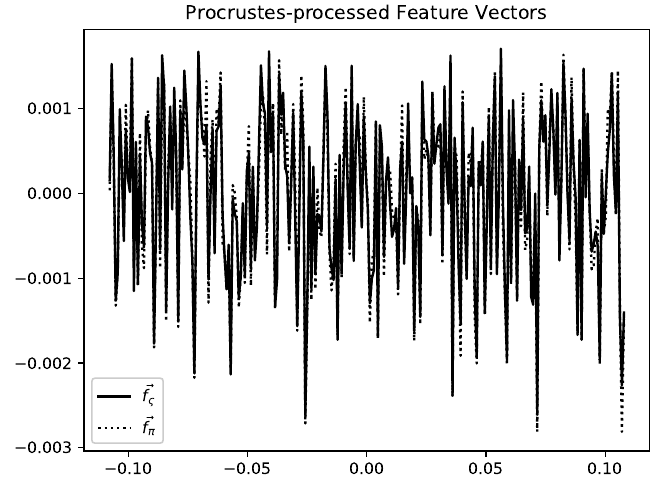
Figure 7. Curves for vectors (cid:126) f ς and the last iteration (cid:126) f π after being pre-processed by Procrustes analysis. Note the similarity of both